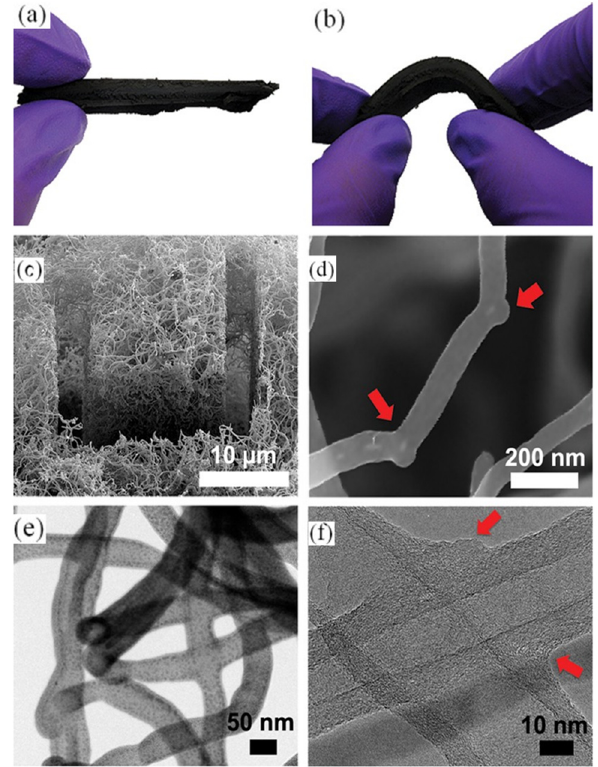
Figure 8. Physical structure and morphology of the CBxMWCNT (boron-doped MWCNT) 3-D network: ( a ) photograph of the 3D macroscopic CBxMWCNT solid sponge material as-produced; ( b ) photograph of the flexibility and mechanical stability upon bending the sample ( a ) by hand; ( c ) SEM image after ion beam “slice and view” feature, showing the interior porous structure of the entangled nanotube network; ( d ) closer look at the “elbow” defects found in the CBxMCWNT solids; ( e ) STEM image showing two, four-way covalent nanojunctions in series; ( f ) TEM image showing two overlapping CBxMCWNTs welded together, assisted by boron doping [125].